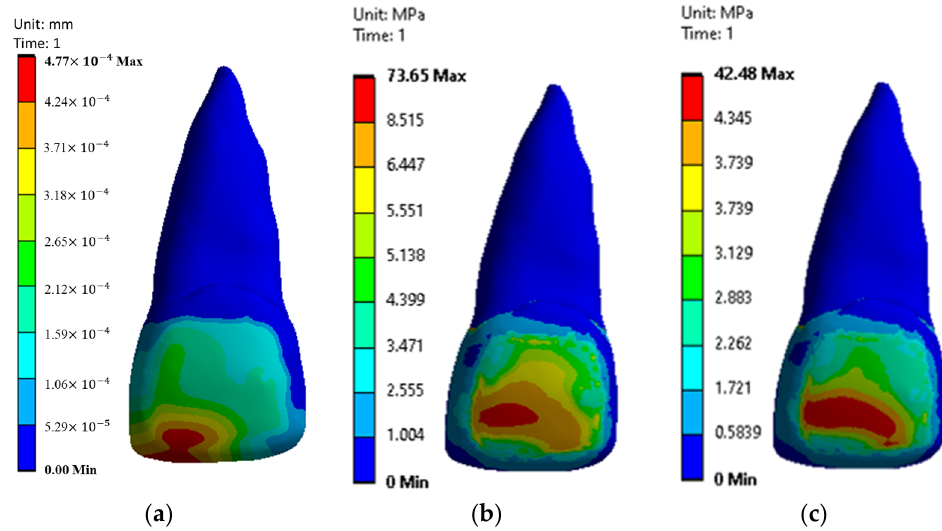
Figure 7. Contours under traumatic loading: ( a ) Displacement, ( b ) von Mises Stress, and ( c ) Shear Stress.